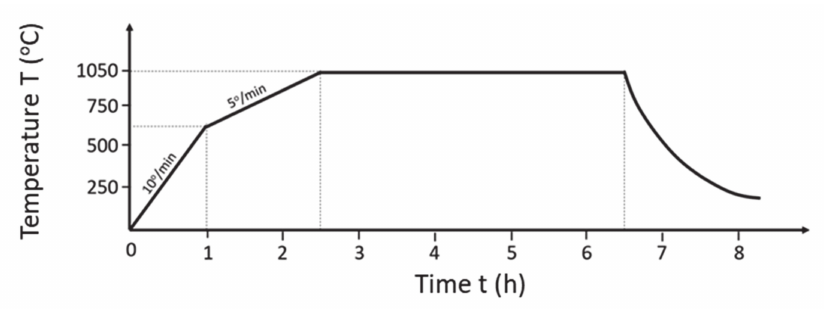
Figure 11. Ageing process heating protocol. Atmosphere: 10% H 2 O in